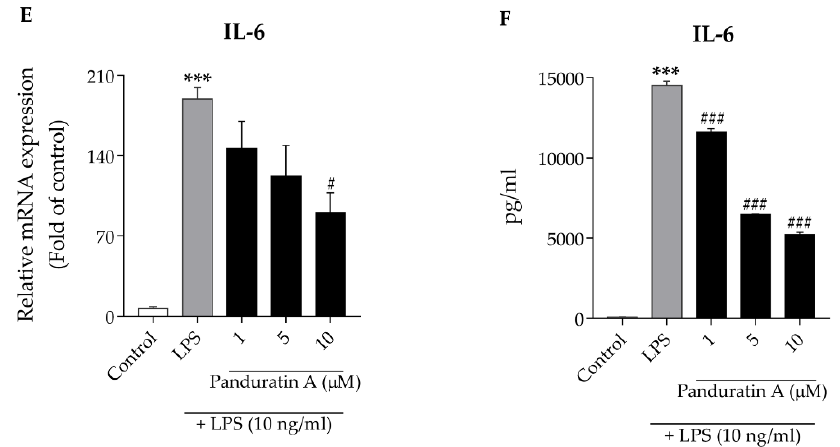
Figure 3. Effect of panduratin A on pro-inflammatory cytokine production against LPS stimulation. Panduratin A decreased mRNA expression of ( A ) TNF- α ; ( C ) IL-1 β ; ( E ) IL-6. Panduratin A reduced cytokine release of ( B ) TNF- α ; ( D ) IL-1 β ; ( F ) IL-6. The control was DMSO treatment. *** p < 0.001 compared to control; # p < 0.05, ## p < 0.01, and ### p < 0.001 compared to LPS-treated cells (one-way ANOVA followed by Tukey’s test).